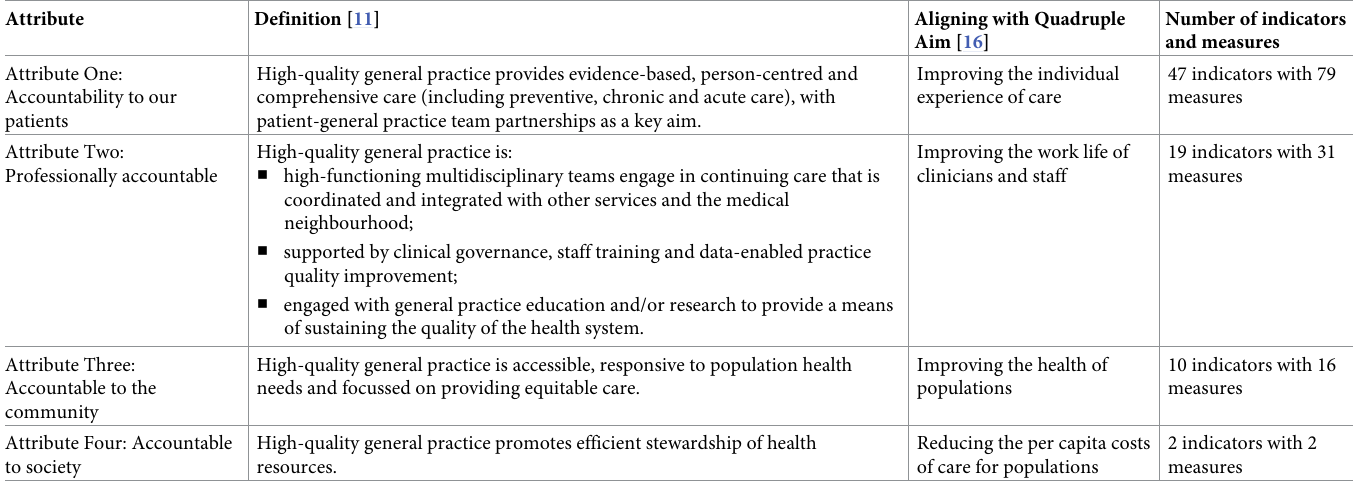
Table 3. High-quality general practice attribute framework, their alignment with the quadruple aim and the number of indicators and measures under each attribute.